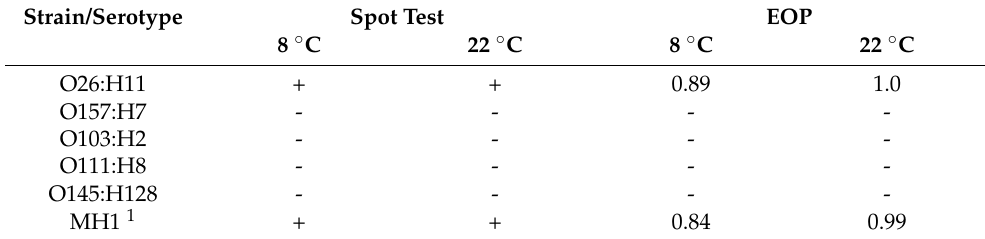
Table 1. Susceptibility of STEC isolates to